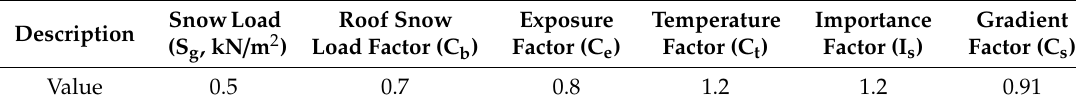
Table 4. Snow load variables.